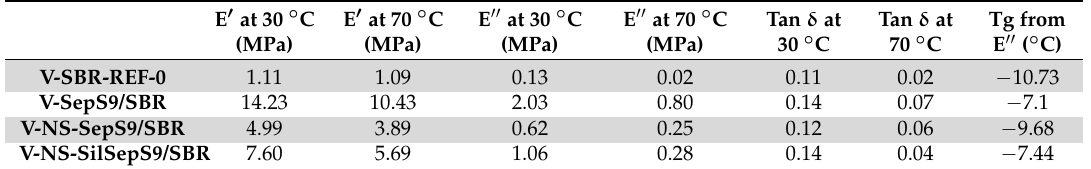
Table 1. E (cid:48) , E (cid:48)(cid:48) , and Tan δ at 30 and 70 ◦ C and Tg from E of SepS9 PNCs.